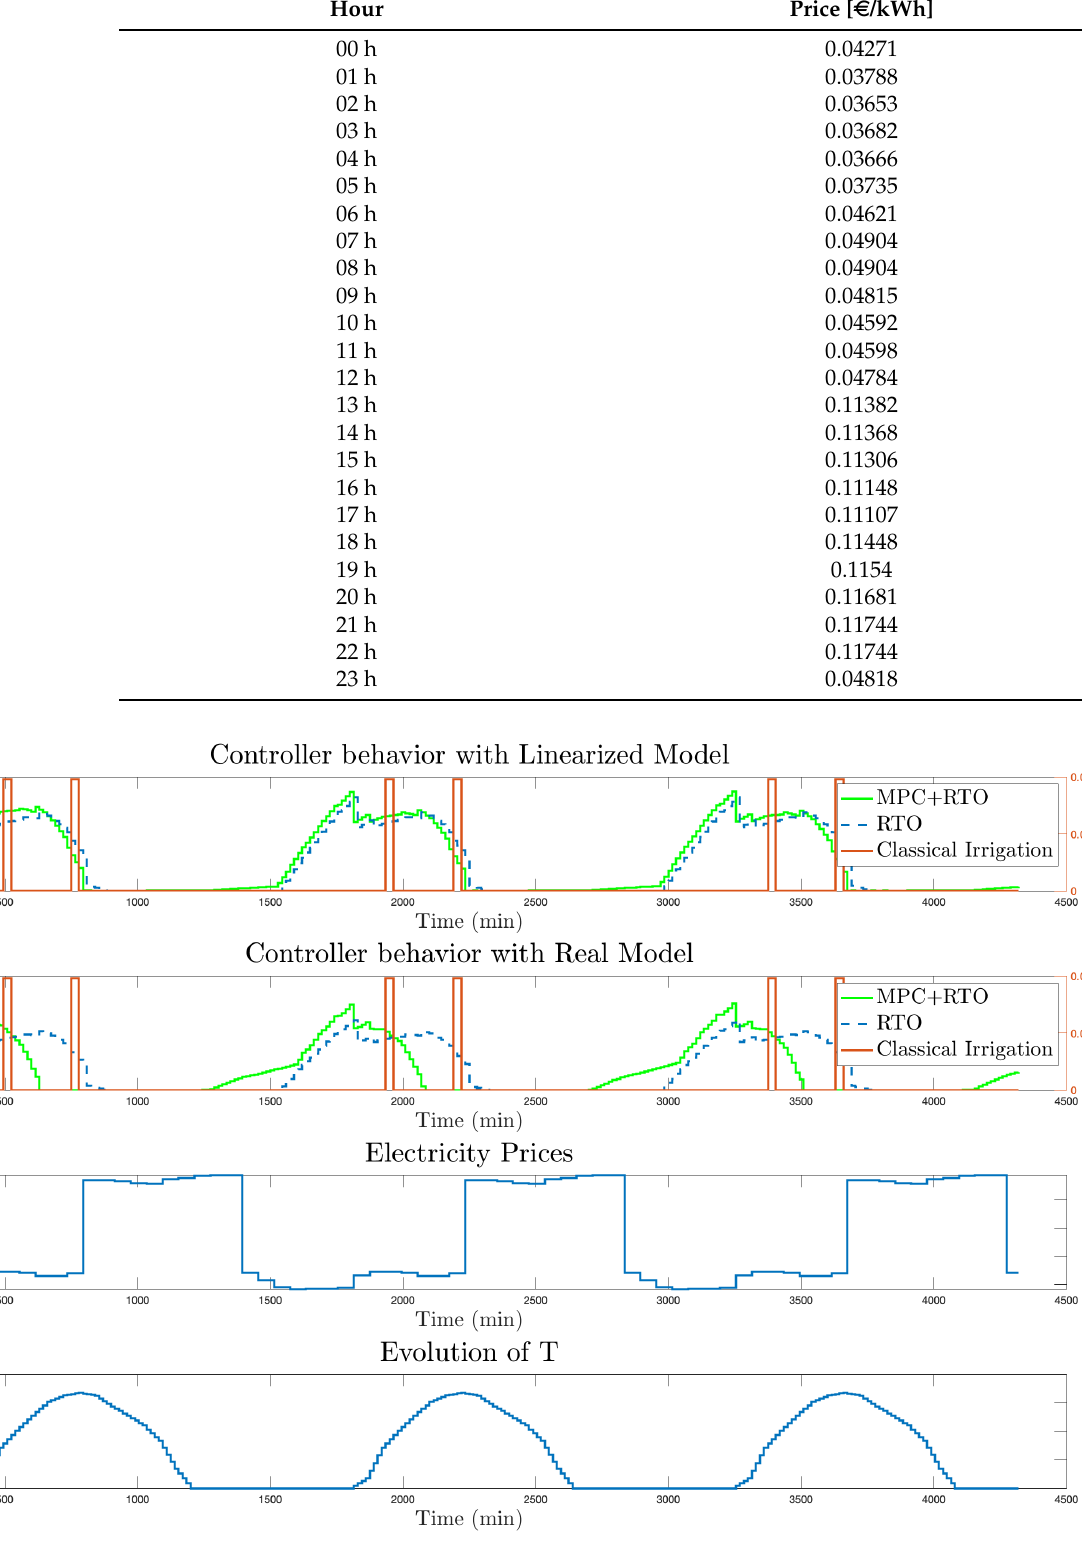
Figure 6. Scaled irrigation flow by the economic MPC controller, optimal consumption by RTO, and classical irrigation strategies during 3 days using ( a ) linearized and ( b ) real (nonlinear) model, ( c ) electricity prices, and ( d )